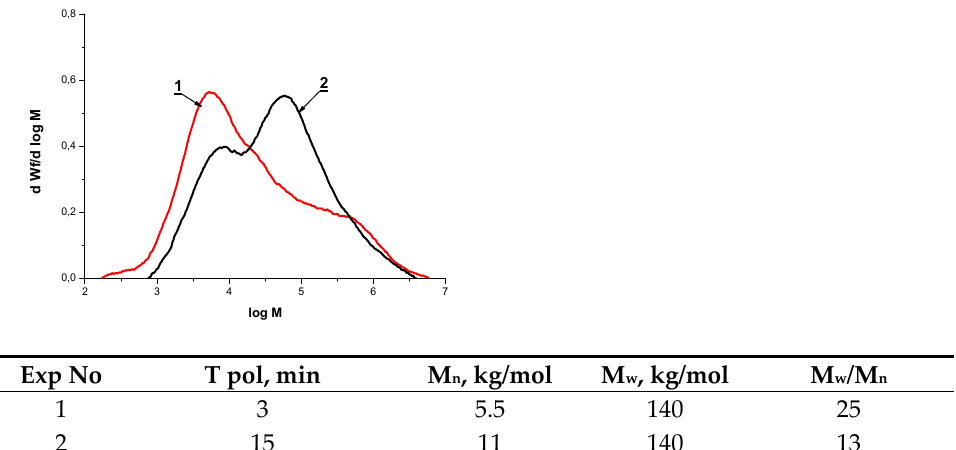
Figure 1. Kinetic curves of ethylene polymerization for exps. 1 and 2 in Table of Figure 2.